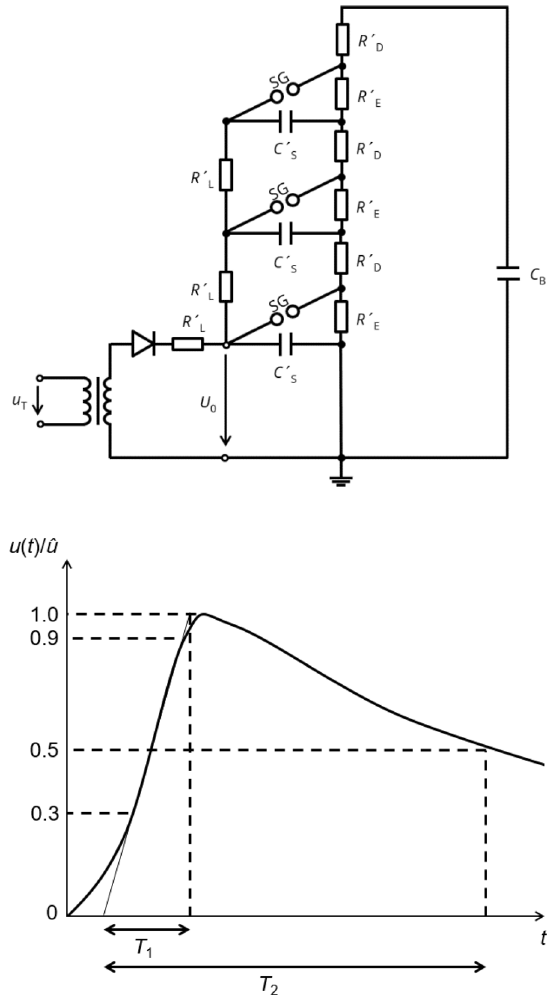
Fig. 2 Three stage impulse voltage generator according to Marx